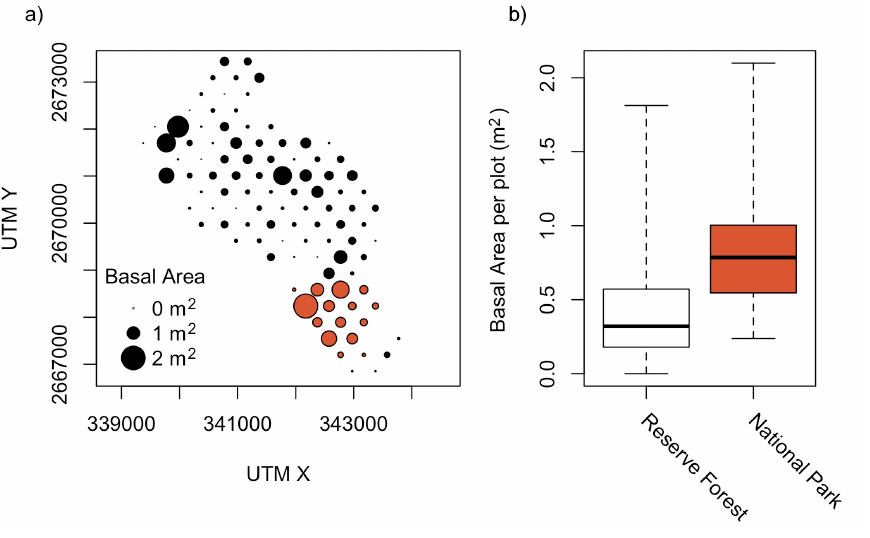
Figure 5. Basal area in National Park and Reserved Forest (a) Spatial pattern of basal area in Satchari National Park (red) and Satchari Reserve Forest (black); (b) Influence of protection status on basal area shows a significant increase in the strictly protected National